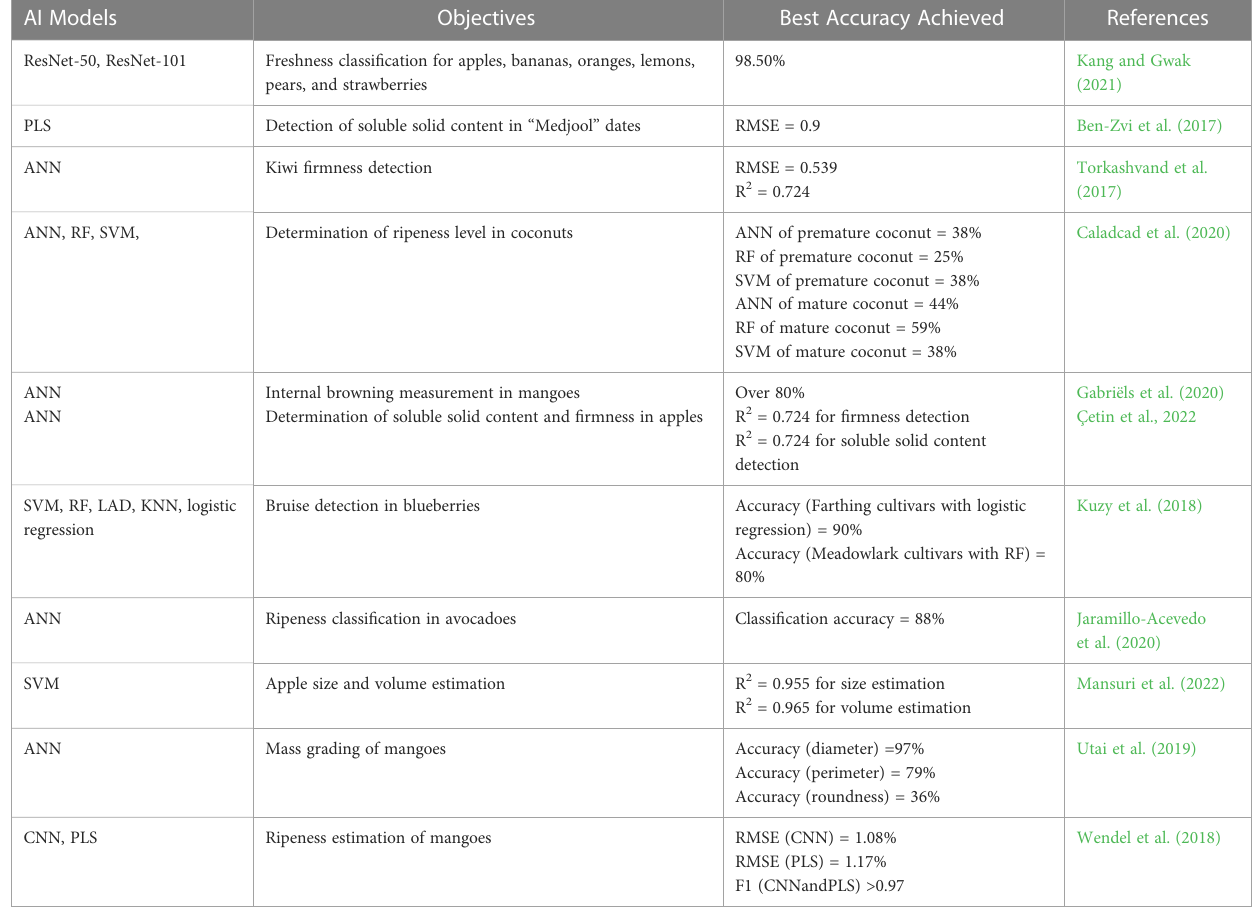
TABLE 4 Accuracy of the AI models for on-farm